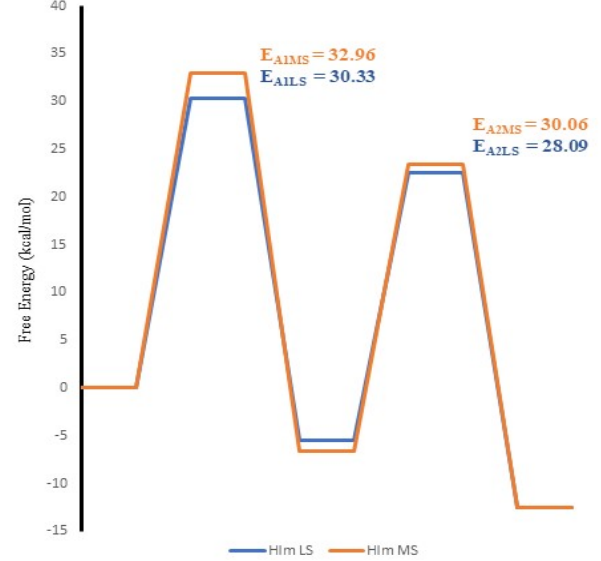
Figure 2. Free energy diagrams (kcal/mol) of HIm catalysed CO 2 cycloaddition, proceeding from the attack of the LB on the more substituted side of the epoxide in orange (HIm MS), in addition to that proceeding from the attack from the less substituted side in blue (HIm LS).